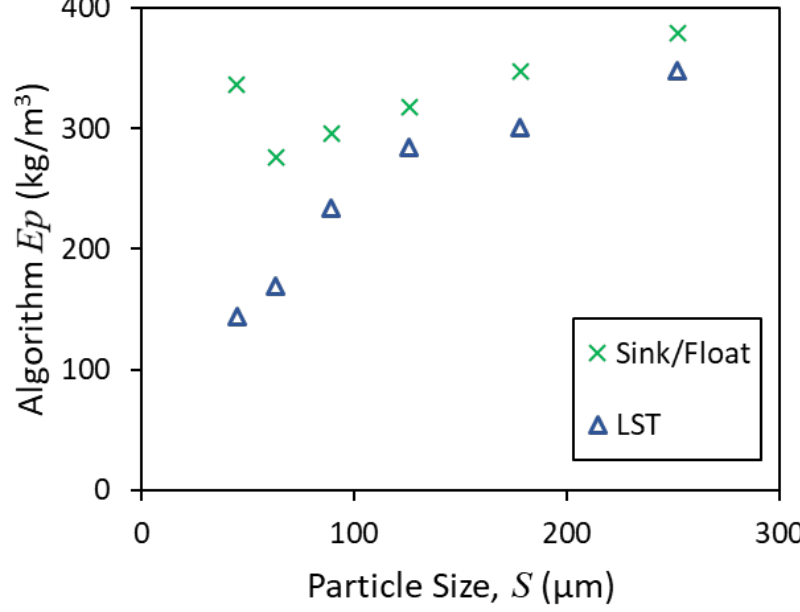
Figure 3. Ecart Probable, Ep , values as a function of particle size generated by applying the algorithm to the raw data from both fractionation techniques. The Ep values based on the LST flow fractionation are in close agreement with the sink/float data above 75 µm, and excellent above 106 µm. RC separation z = 3 mm; RC flow fractionation z = 1.77 mm.